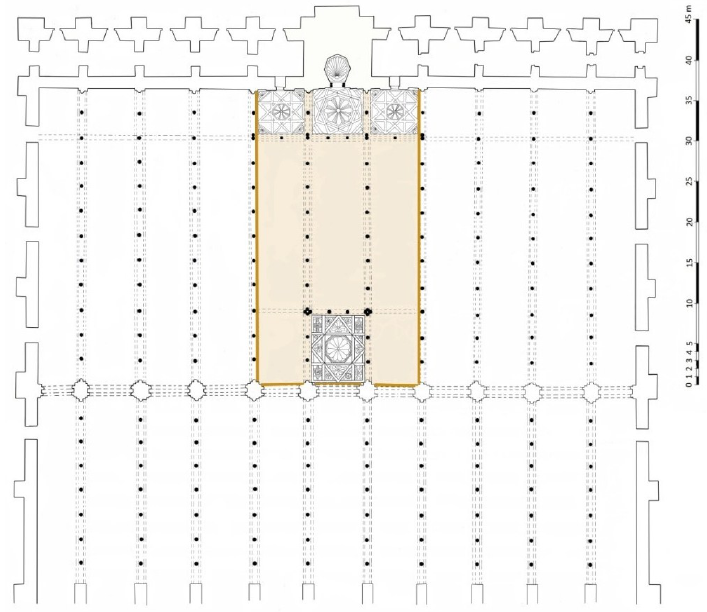
Figure 8. Floor plan of the extensions of the Great Mosque of Cordova during the emirate of ‘Abd al- Ra ḥ man II (822–855) and the Umayyad caliphate of al- Ḥ akām II. Detail of the longitudinal maq ṣ ūra (Abad Castro 2009, p. 11, Figure 2).